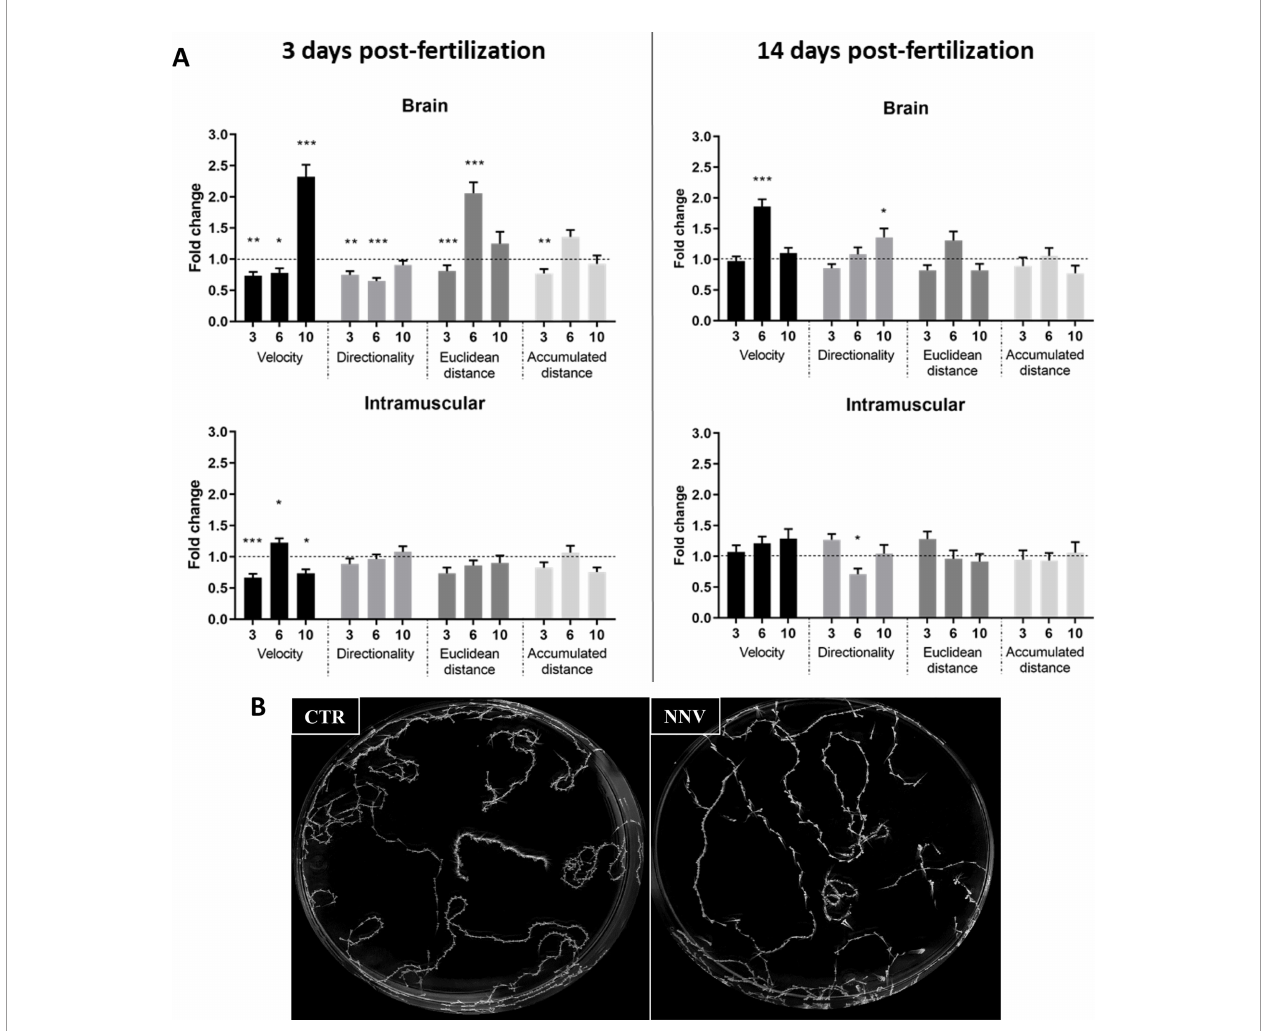
FIGURE 2 | Image analysis of the swimming behavior of zebra fi sh larvae (3 and 14 dpf) infected with NNV via brain or IM. (A) Comparison of velocity, directionality, accumulated distance and Euclidean distance parameters between NNV-infected and the corresponding uninfected control larvae. Video tracking of zebra fi sh larvae was conducted at different times postinfection (3, 6, and 10 dpi). The fold change (FC) of infected larvae compared with their uninfected control (Control FC = 1, dotted lines) was calculated. The graphs represent the mean ± SEM of the biological replicates. Statistically signi fi cant differences are displayed as follows: ***, 0.0001 > p value > 0.001; **, 0.001 > p value > 0.01; *, 0.01 > p value > 0.05. (B) Example of maximal projection of the video recorded for 3-dpf larvae infected via brain and the corresponding controls at 6